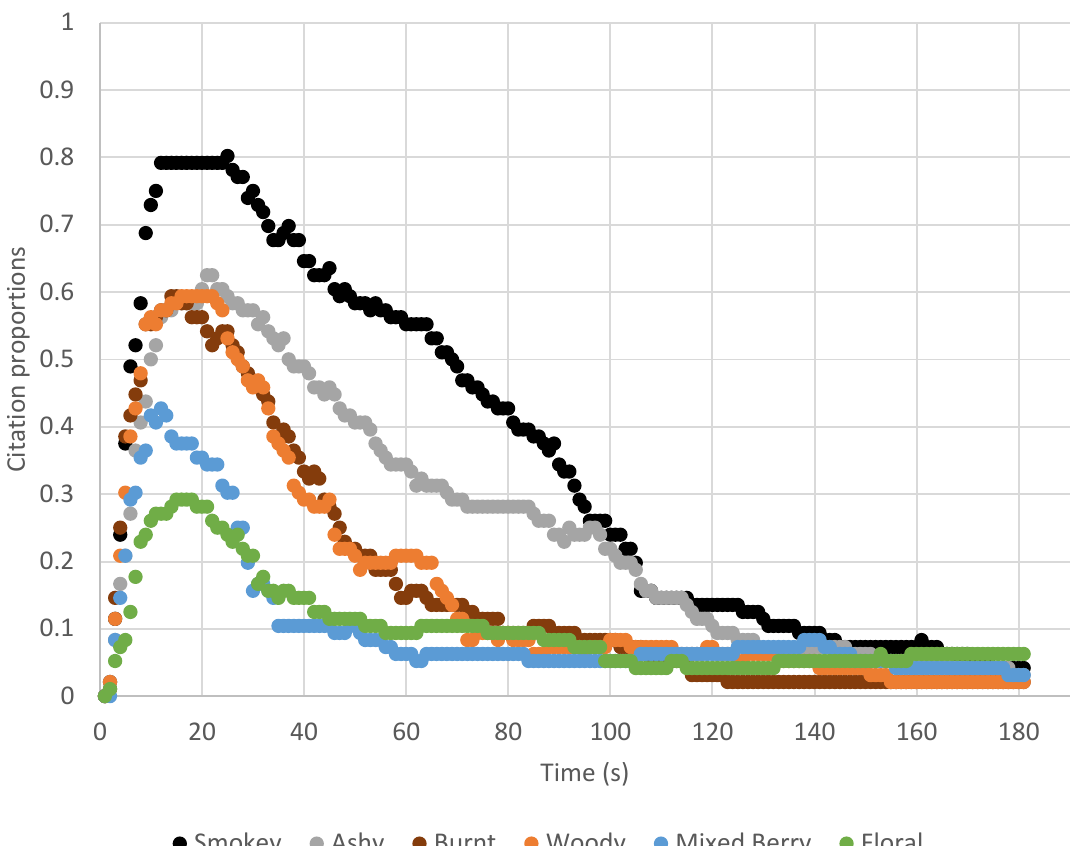
Figure 1. Temporality of TCATA attributes based on the proportion of overall citations in 1 s intervals over 180 s for the high smoke phenol wine.